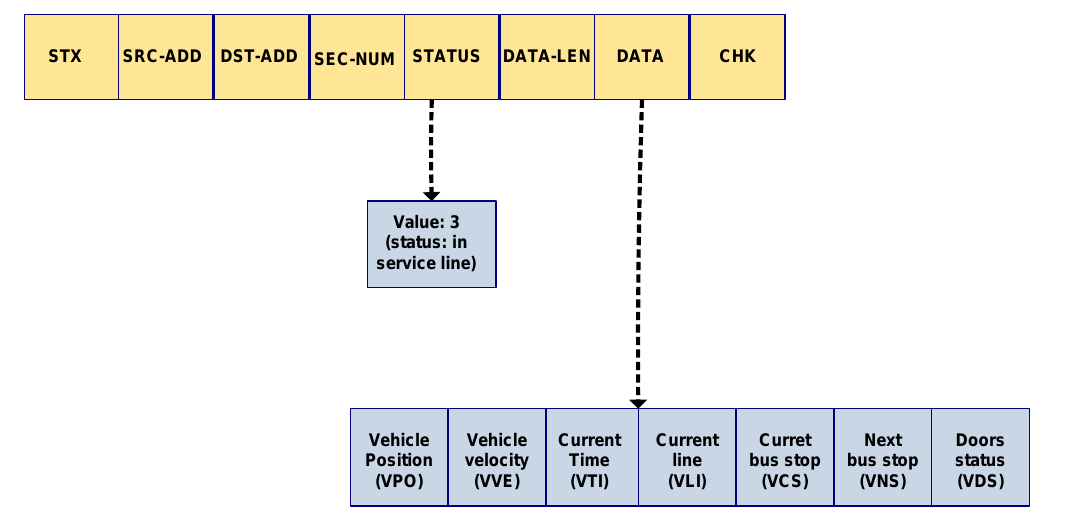
Figure 5. Details of the data communicated via the